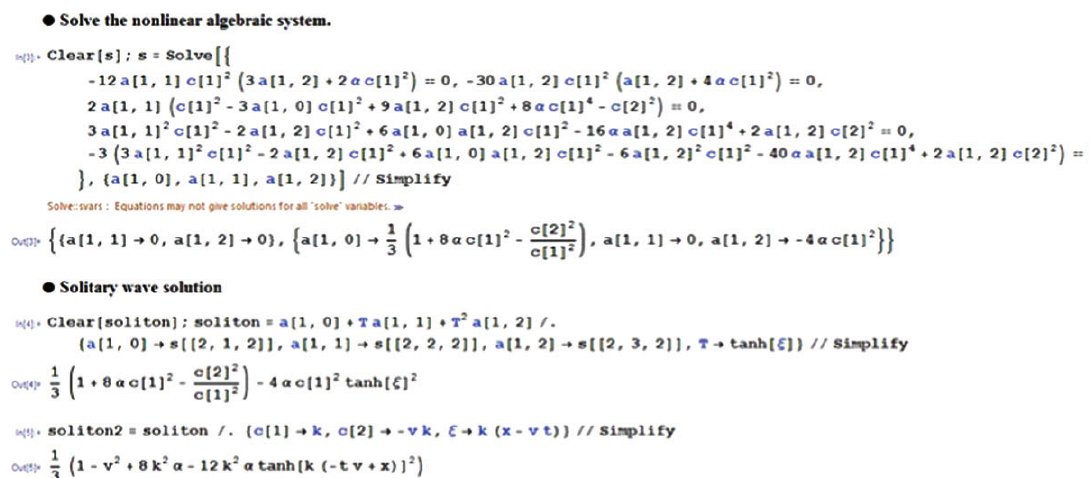
Figure 11 Boussinesq wave equation by using Mathematica ® : wave solution in tanh.